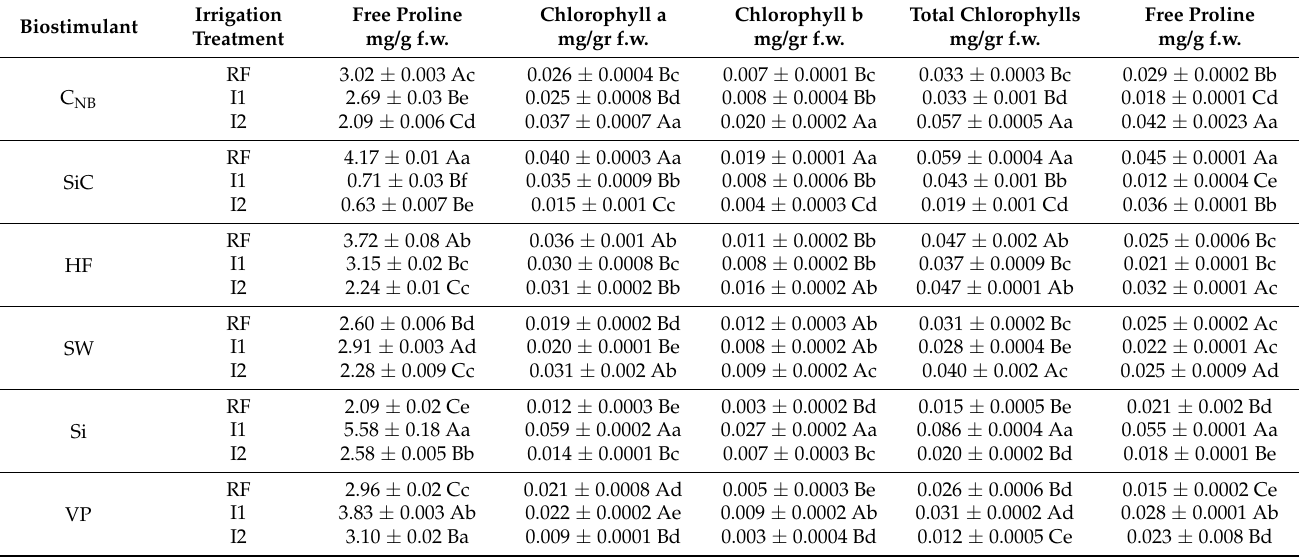
Table 6. Content of free proline, chlorophylls (chlorophyll a, b, and total chlorophylls), and carotenoids of Batavia-type lettuce plants in relation to irrigation regime and biostimulant application (means ±